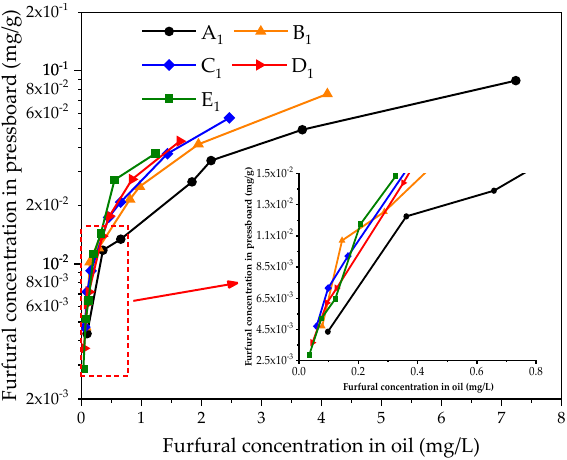
Figure 6. The relationship between furfural concentration in oil and that in pressboard.